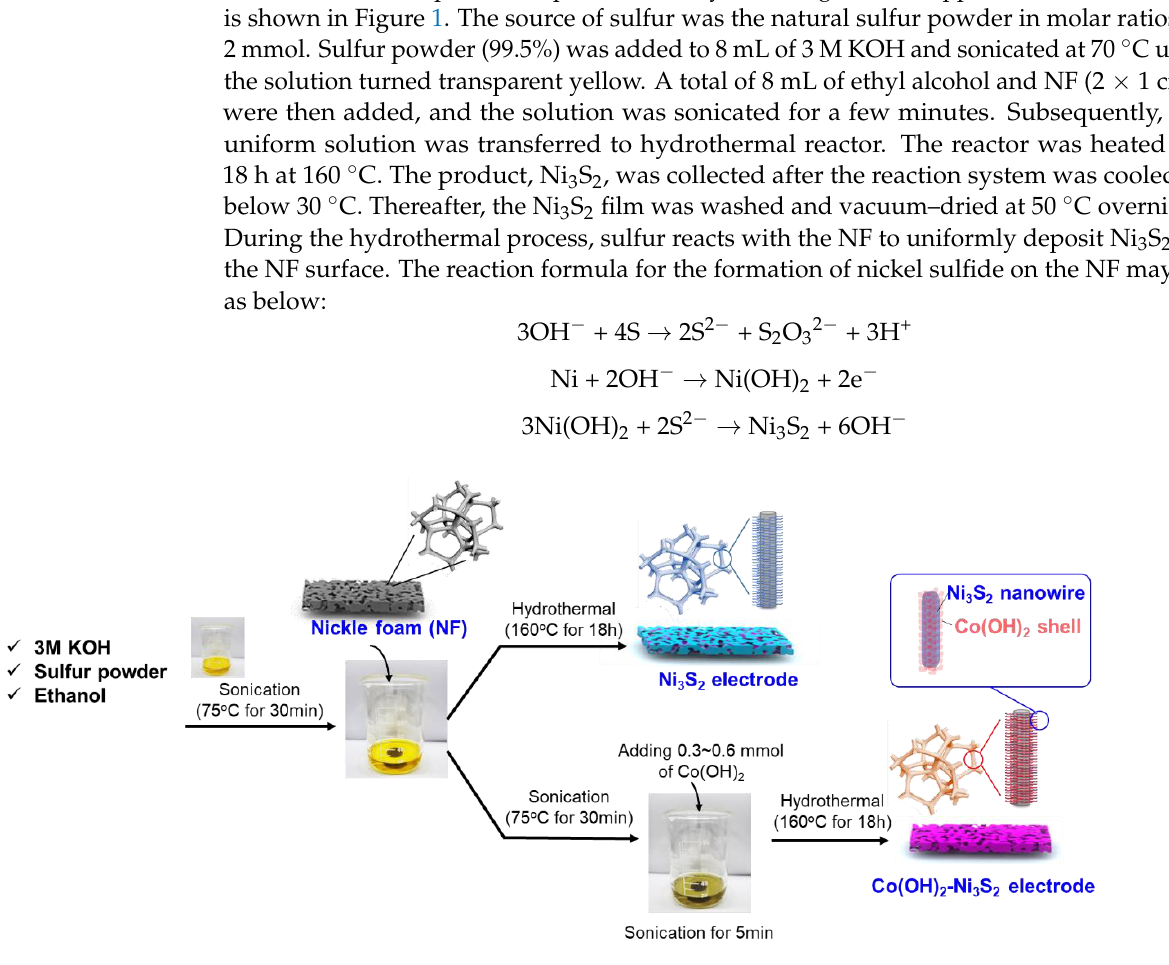
Figure 1. Schematic diagram of hydrothermal Ni 3 S 2 and Co(OH) 2 –Ni 3 S 2